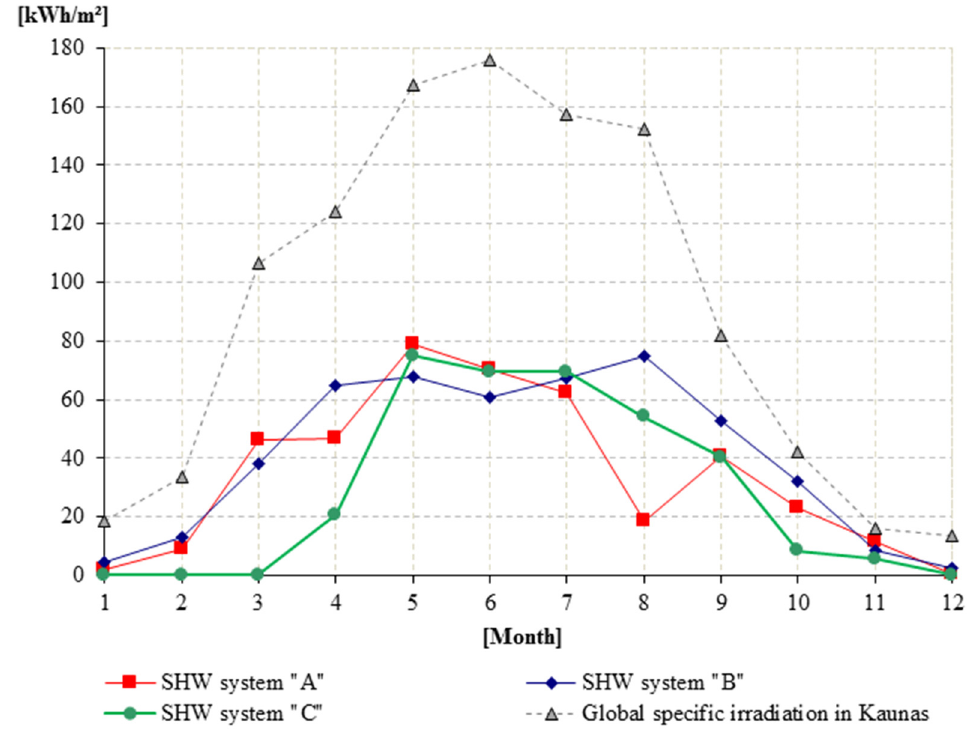
Figure 2. Amount of energy produced in the analysed systems (kWh/m 2 absorber ) per month and measured global irradiation in Kaunas